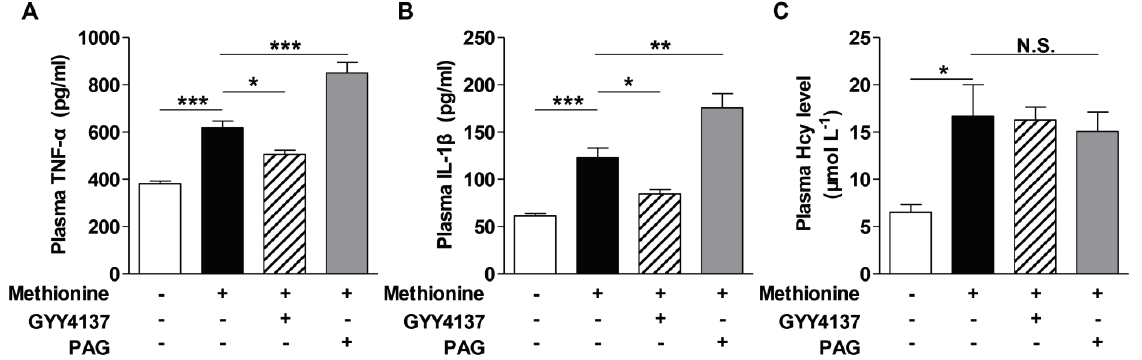
Figure 1. Plasma homocysteine (Hcy) ( A ), hydrogen sulfide (H 2 S) ( B ) and cytokines levels ( C , D ), as well as cystathionine γ -lyase (CSE) mRNA ( E ) and protein expressions ( F ) in the peritoneal macrophages of C57BL/6 mice with or without methionine-supplementation. The measurements of Hcy, H 2 S and cytokines level were performed as described in Materials and Methods. CSE mRNA level was examined by quantitative PCR while its protein expression determined by immunoblotting analysis. 18S mRNA and glyceraldehyde- 3-phosphate dehydrogenase (GAPDH) protein served as loading controls. Results are presented as mean ± SEM, n = 4–7 in each group. * p < 0.05, ** p < 0.01, *** p < 0.001 compared to control